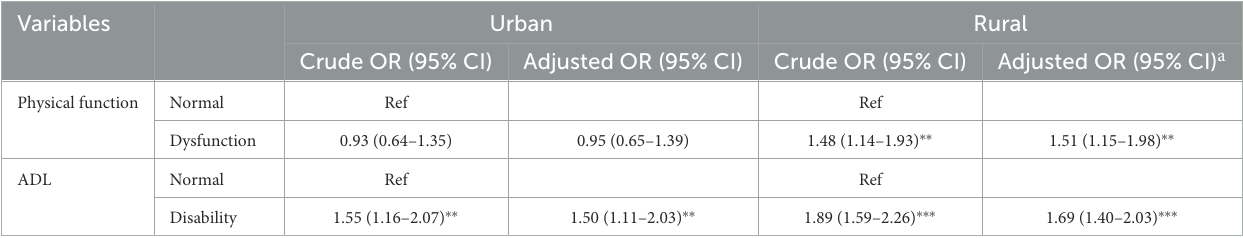
TABLE 4 OR with 95% CI of depressive symptoms according to the physical function and ADL stratified by urban and rural in 2015.